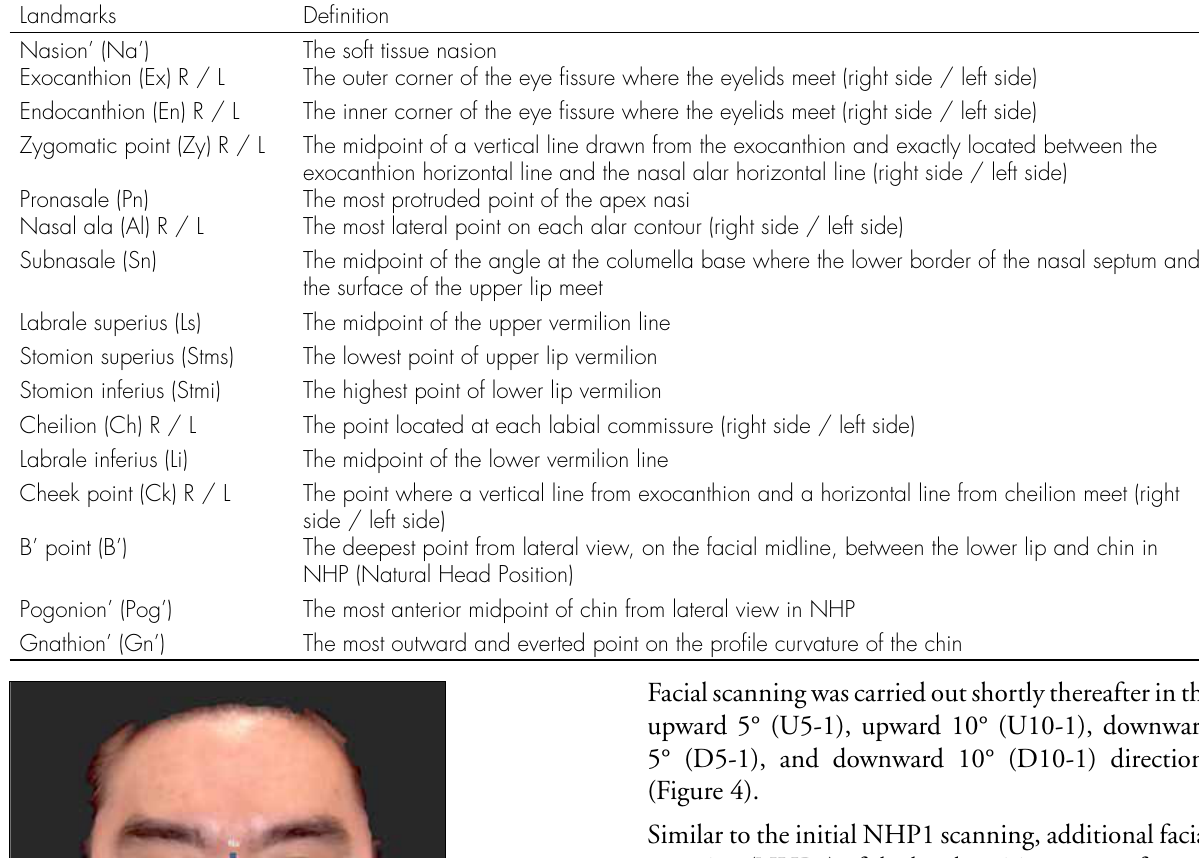
Table I. Description of 3D soft tissue landmarks in the study.